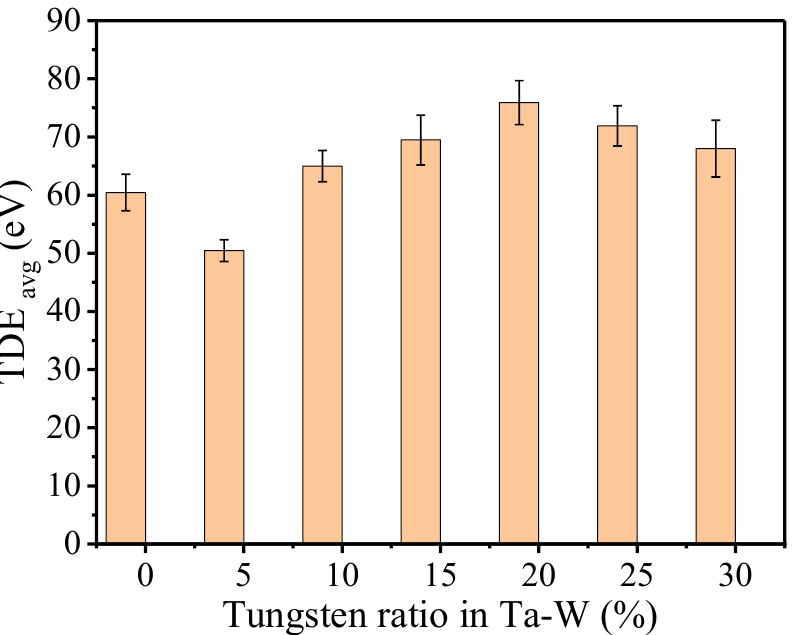
Figure 3. The results of TDE averaged over 210 ICD, for four different vibrational timings and for six different structures at specific W % contest in Ta – W alloy.